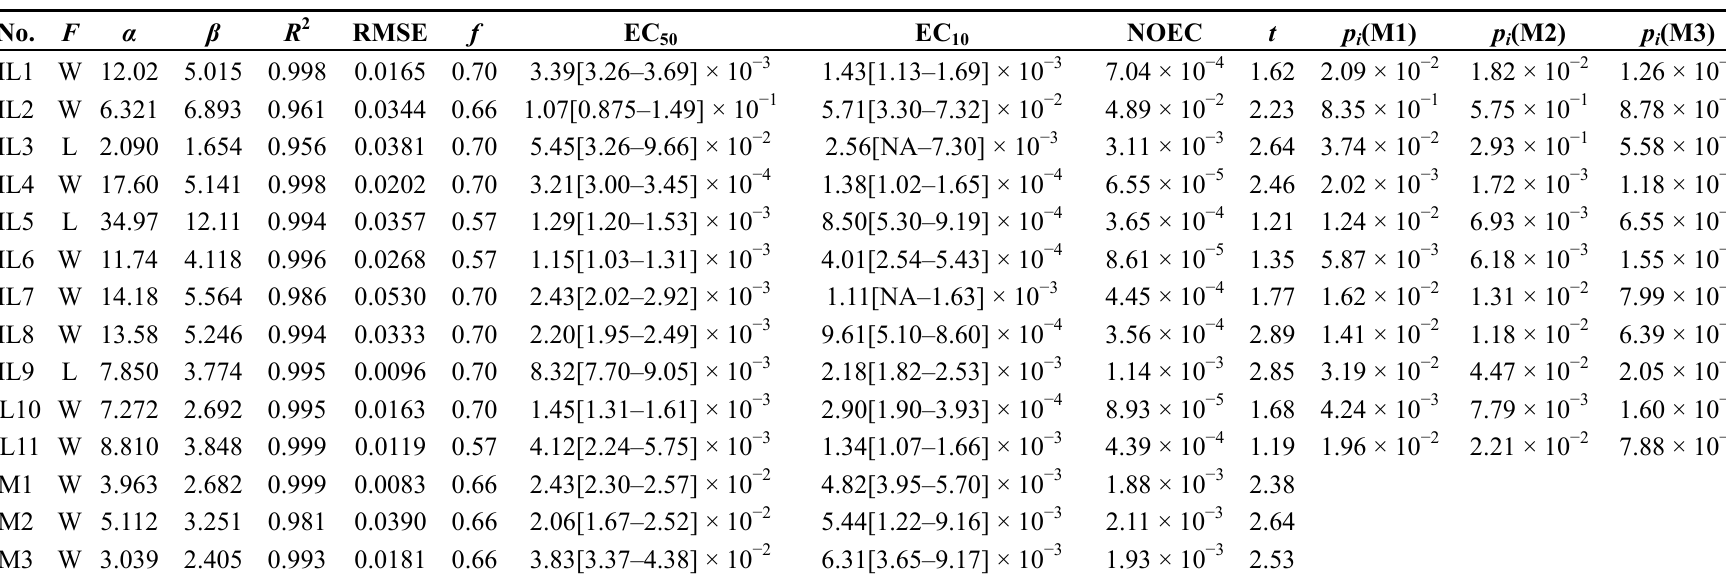
Table 1. Concentration–response models of individual ionic liquids and their mixtures on the inhibitory effects of luciferase luminescence and some statistics.